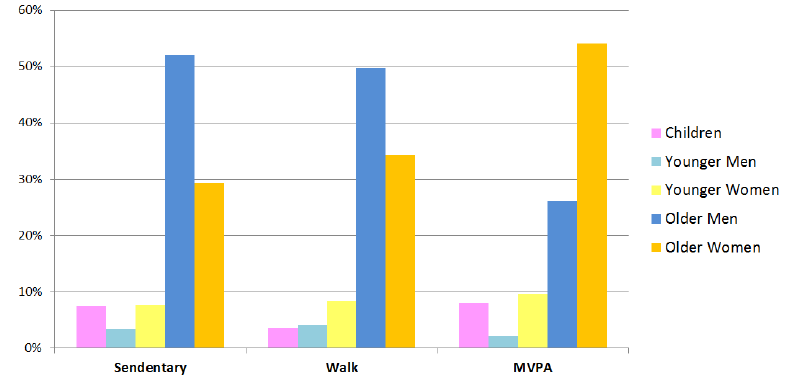
ff erent age and gender